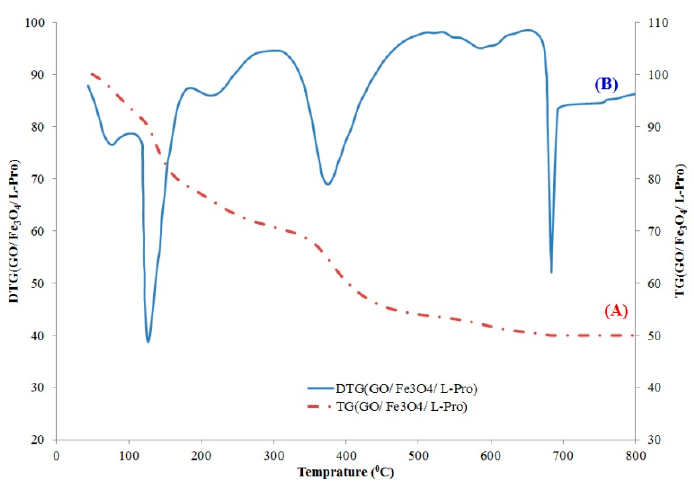
Figure 3. TGA ( A ) and DTG ( B ) curves of GO/Fe 3 O 4 / L -pro hybrid.